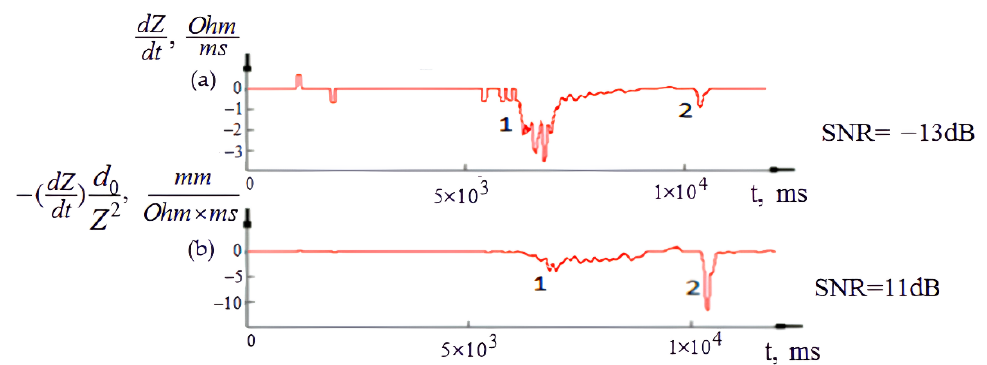
Figure 7. The recording electrical impedance signal and its derivative after the normalization procedure. Table 3. Characteristics of electrical impedance recording during